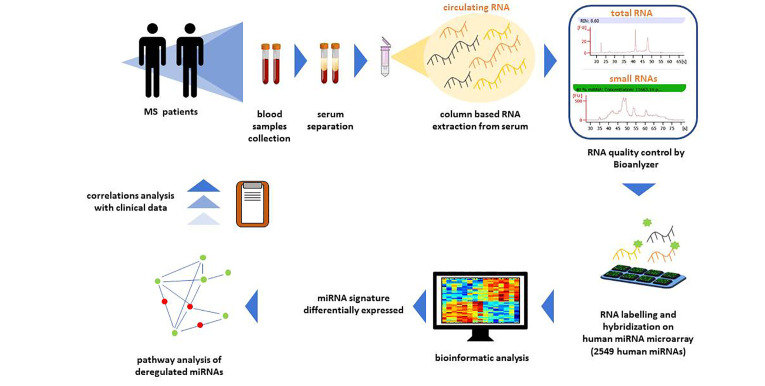
Workflow of circulating miRNA profiling. For circulating miRNA profiling blood samples from patients will be processed. In particular, circulating RNA will be extracted from serum samples with a column-based extraction method. Total and small RNA quality will be assessed by Bioanalyzer. Then, total RNA will be labelled for the hybridization to Human miRNA Microarray Release 21 (Agilent) containing probes for 2549 human miRNAs. Microarray data will be subjected to bioinformatic analysis to identify a signature of miRNAs differentially expressed. Deregulated miRNAs pathway analysis and correlations analysis with clinical variables will be performed.